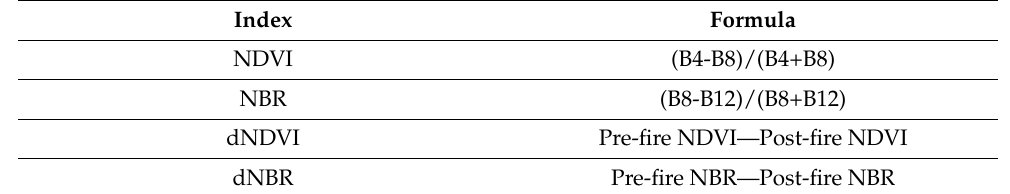
Table 2. Table showing the indices tested and the formula used to calculate